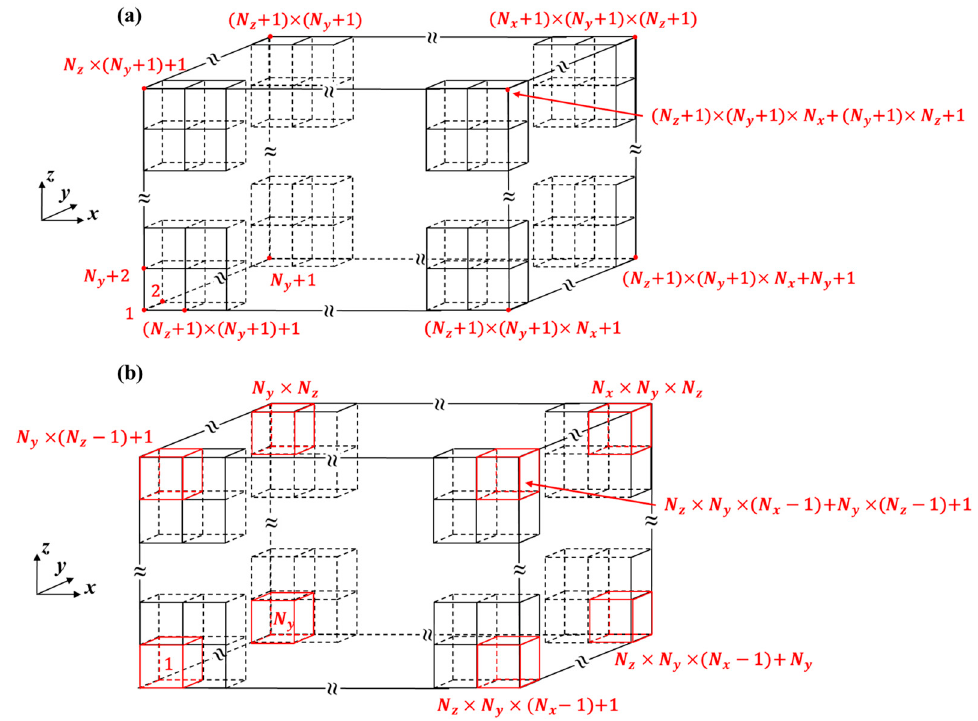
Figure 2. ( a ) Global node numbering and ( b ) element numbering schemes for cold-rolled plates.